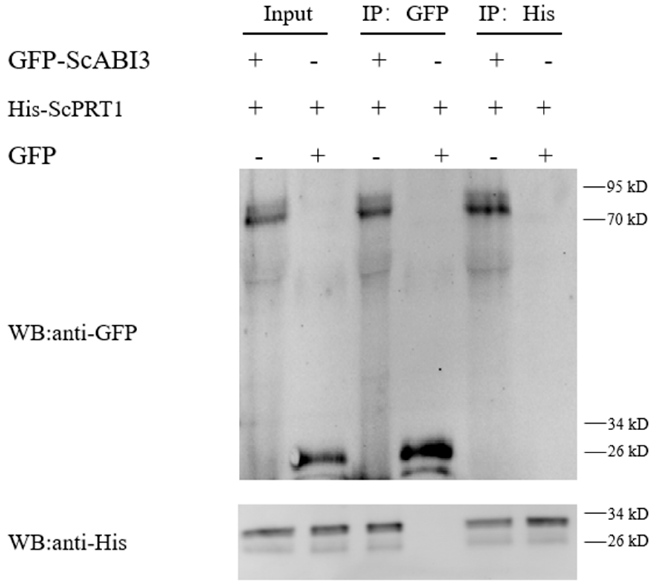
Figure 3. Interaction test by Y2H assay. The transformed cells were plated onto SD-T: -trp, SD-L: -leu; SD-TL: -trp, -leu; SD-TLH: -trp, -leu, -his; SD-TLHA: -trp, -leu, -his, -ade medium. The known pGBKT7-p53 + pGADT7-largeT vector was used as a positive control, and the pGBKT7-laminC + pGADT7-largeT vector was used as a negative control.